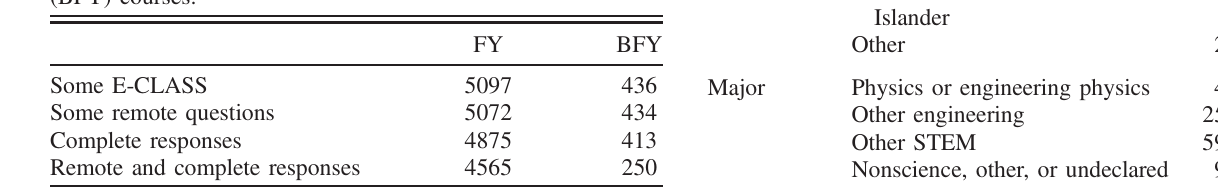
Some remote questions Complete responses Remote and complete responses